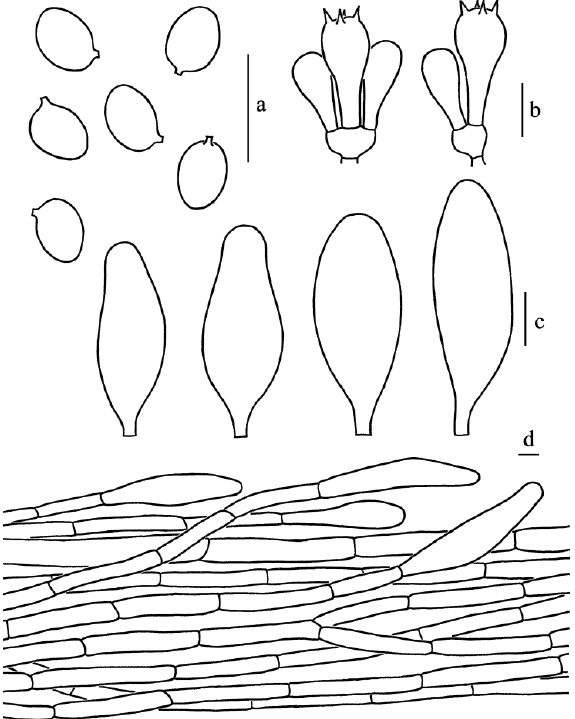
Figure 3. Leucoagaricus albosquamosus (CFSZ20662). ( a ) Basidiospores. ( b ) Basidia. ( c ) Cheilocystidia. ( d ) Elements of pileus squamules. Scale bars: 10 μm.